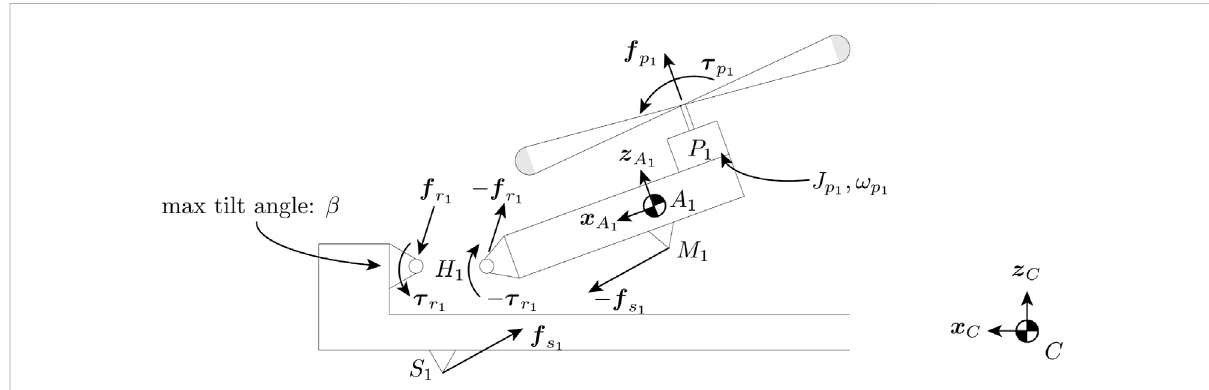
FIGURE 4 Free-body diagram showing the forces acting on arm 1 viewing from the left side. The length of the arm is exaggerated. A spring is attached between point S 1 on the quadcopter central body and M 1 on the arm. The spring exerts a torque that tries to keep the arm in the untilted direction.Themomentumofinertiaoftherotorarounditsaxisis J p con fi guration.Thepropellerproducesathrustforce f p i andatorque τ p i inthe z A 1 and the rotor rotates at a speed of ω p . 1